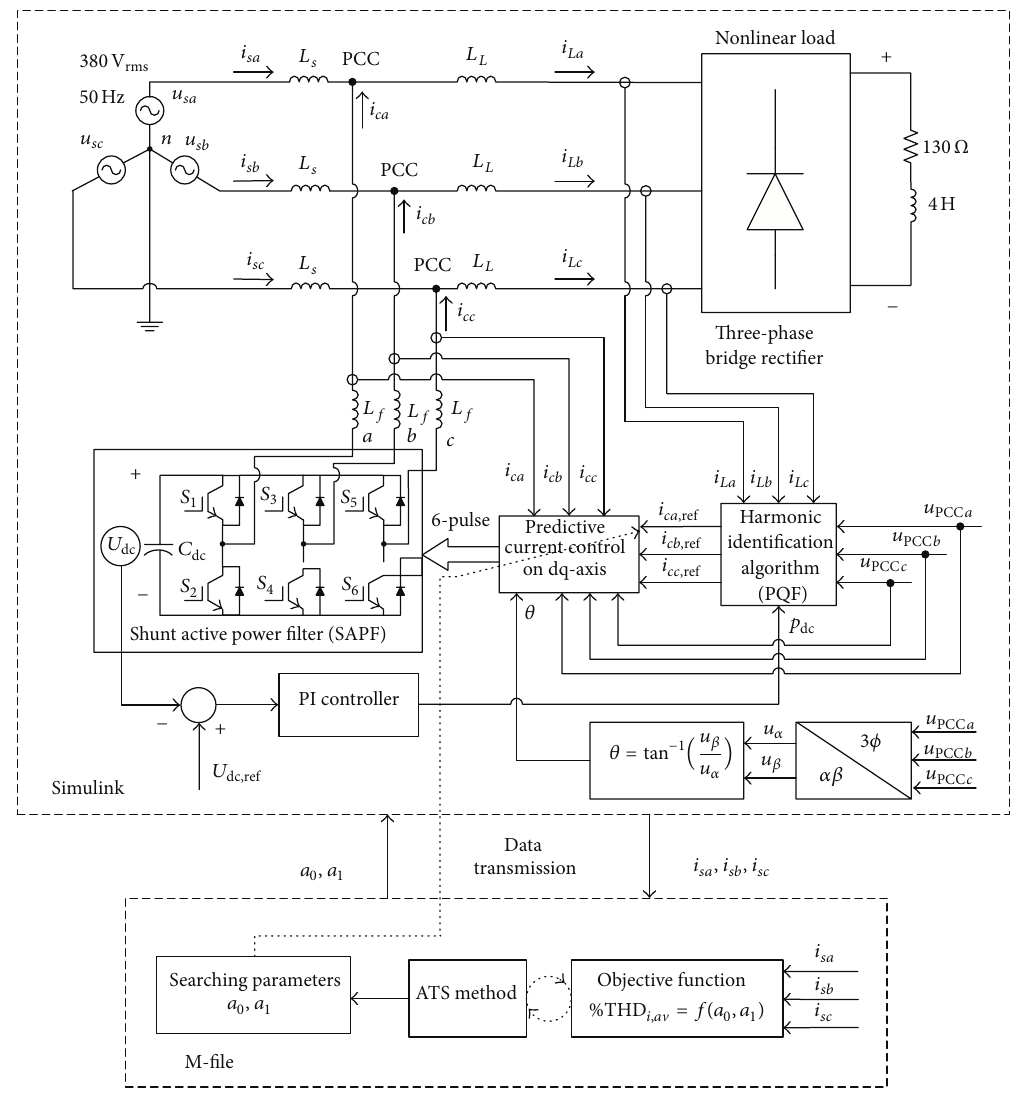
Figure 21: The design of predictive current controller using ATS